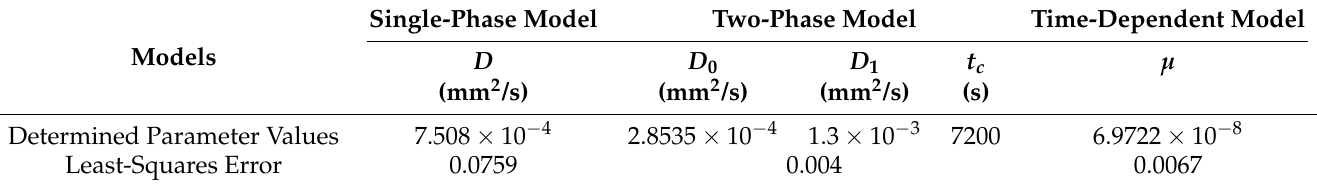
Table 1. The determined parameter values and the least squares error for each